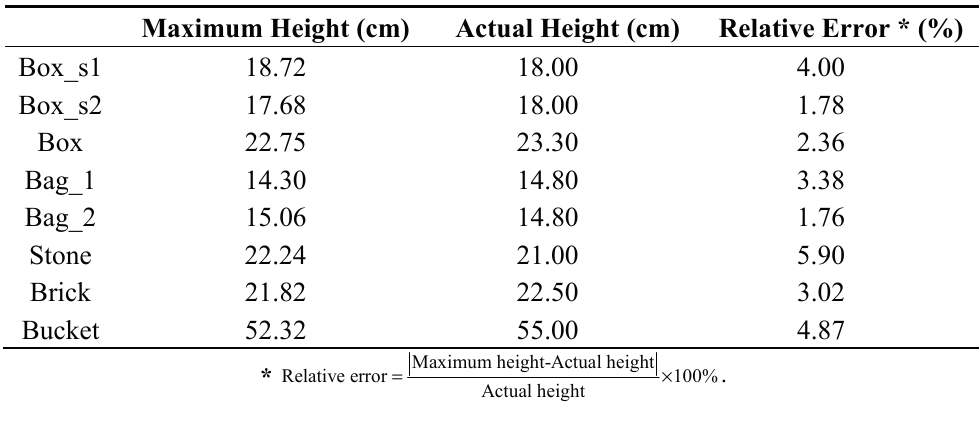
Table 2. Analysis of height calculation.